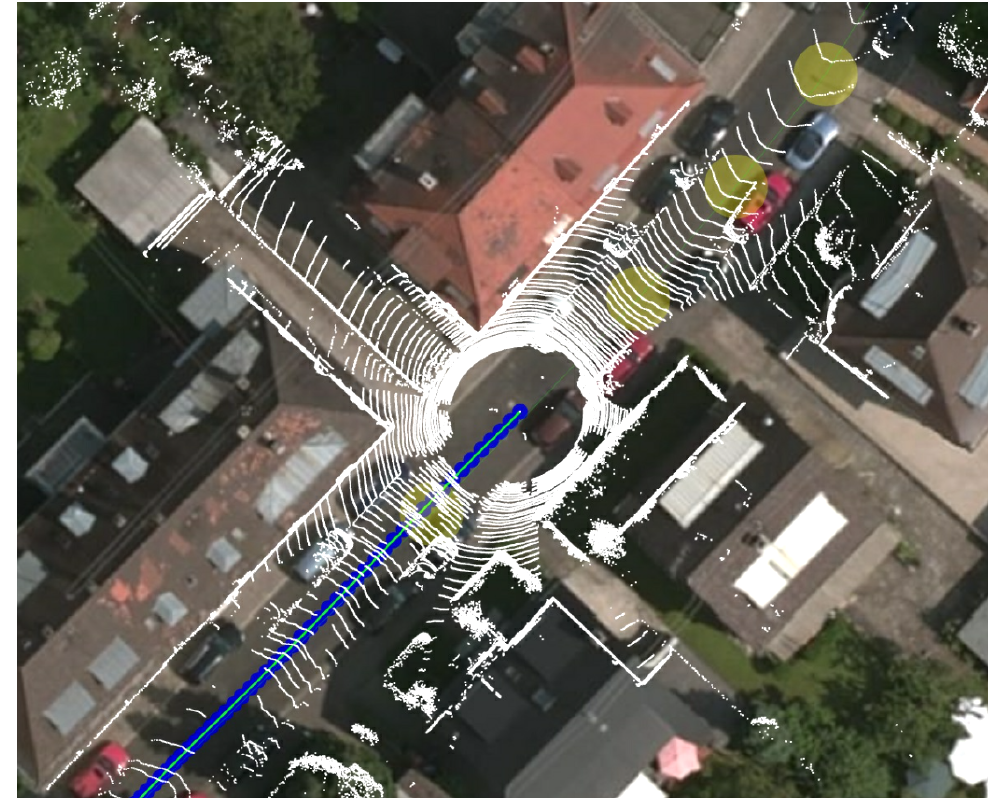
Figure 3. The figure depicts how we compared the velodyne data to the airbone images and the OpenStreetMap data. White points correspond to the Light detection and ranging (LIDAR) measures associated with the KITTI ground truth